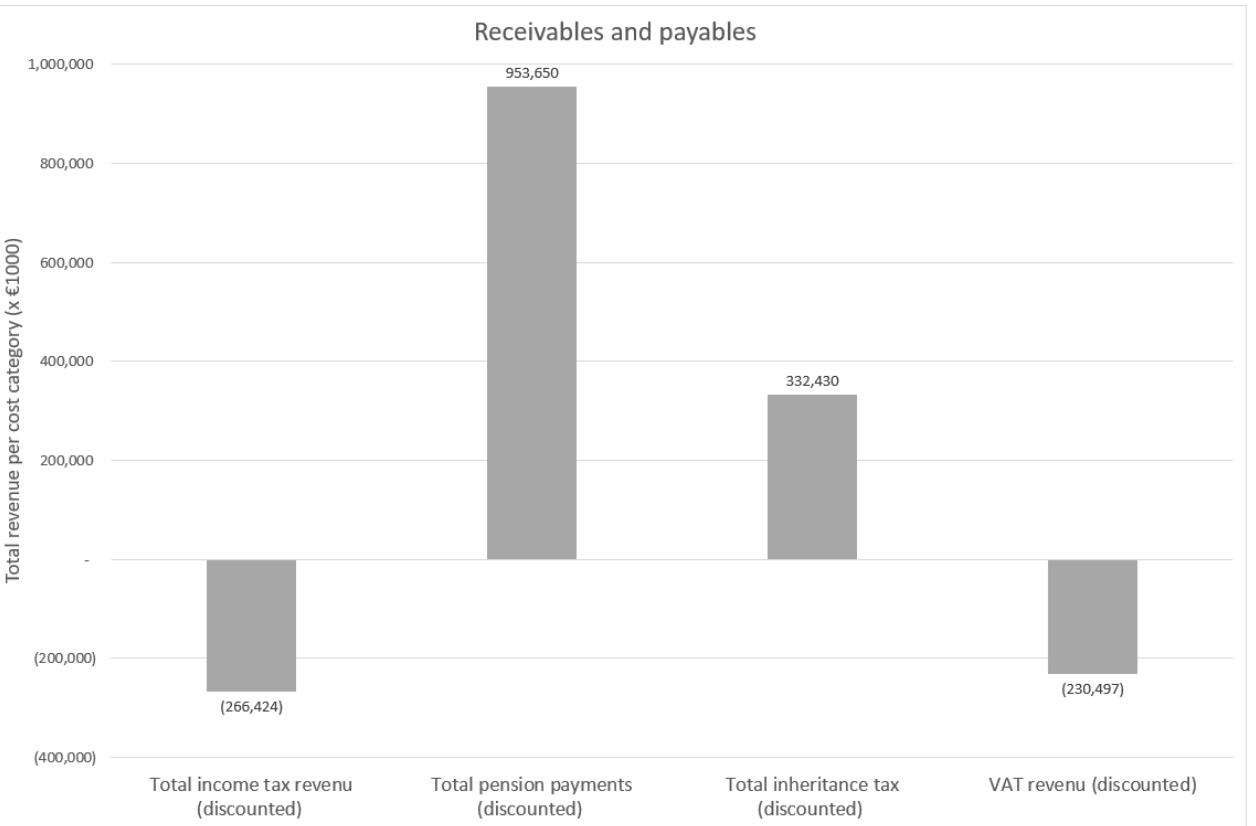
Figure 4. Total amount of receivables and payables. Description: The values were derived from multiplying population data in 2020 and 2021 with the age-group-specific consequences on the four government cost categories. The effects of COVID-19 on work disability were excluded, as described in more detail earlier.